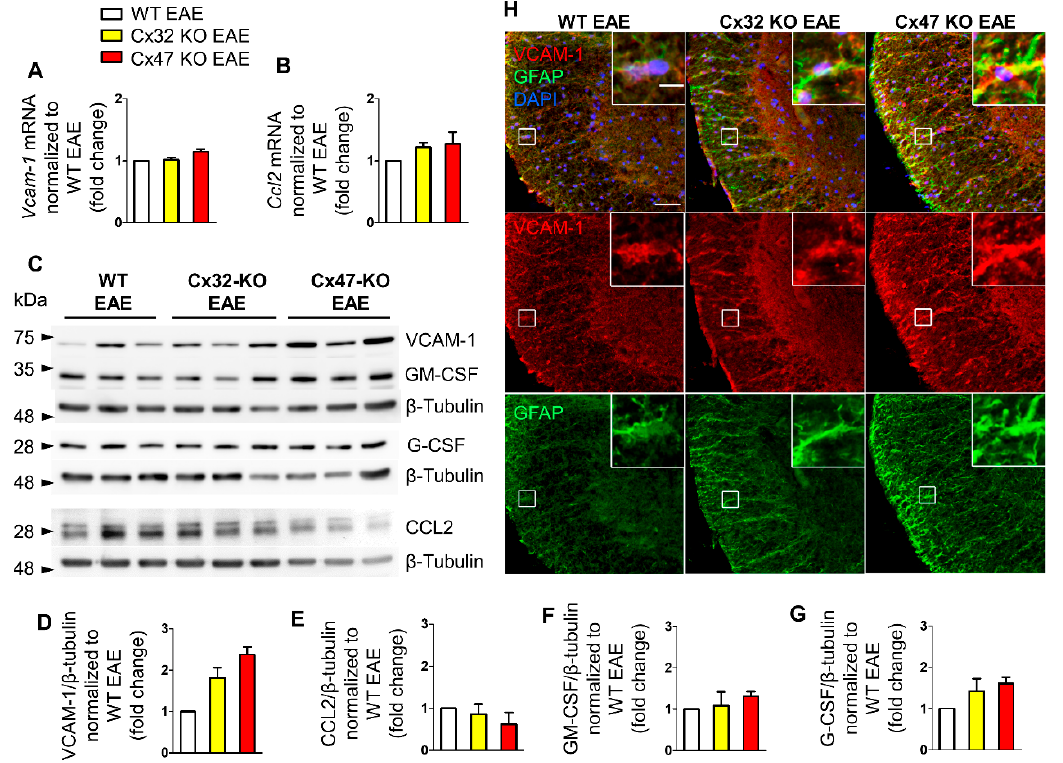
Figure 2. Expression of inflammatory cytokines in the lumbar spinal cord of Cx47 KO and Cx32 KO compared to WT EAE mice at 7 dpi. ( A , B ) Assessment of Vcam-1 ( A ) and Ccl2 ( B ) relative mRNA transcript levels via RT-qPCR in the lumbar spinal cord of n = 4 WT EAE, n = 4 Cx32 KO EAE, and n = 3 Cx47 KO EAE mice (all with a clinical score of 0) at 7 dpi. Gapdh was used as an internal control. Data are presented as mean ± SD. ( C – G ): Representative immunoblot ( C ) of lumbar spinal cord tissue lysates from n = 3 WT EAE, Cx32 KO EAE, and Cx47 KO EAE mice (all with a clinical score of 0) at 7 dpi with quantification of relative protein levels of VCAM-1 ( D ), CCL2 ( E ), GM-CSF ( F ), and G-CSF ( G ). β -Tubulin was used as loading control. Data are presented as mean ± SD. One-way ANOVA with post hoc Tukey’s HSD test was used for all comparisons. ( H ) Representative immunofluorescence images of the anterolateral lumbar spinal cord region from cross sections obtained from 7 dpi WT EAE and Cx47 KO EAE mice stained with antibodies against VCAM-1 (red), and the astrocytic marker GFAP (green). Nuclei are counterstained with DAPI (blue). Single channels and overlap images are shown as indicated. Magnified views from squared boxes are depicted in insets. Scale bars: in overview 50 μ m; in insets 10 μ m.